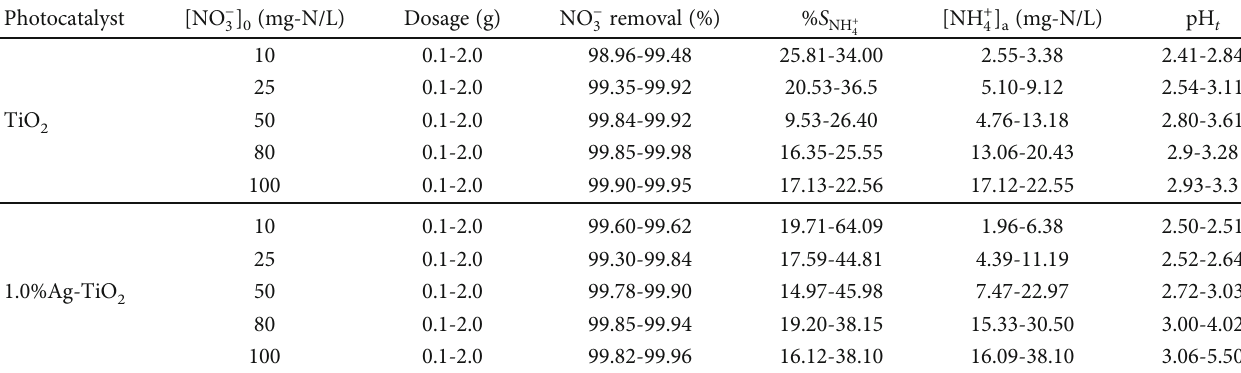
photocatalysts at